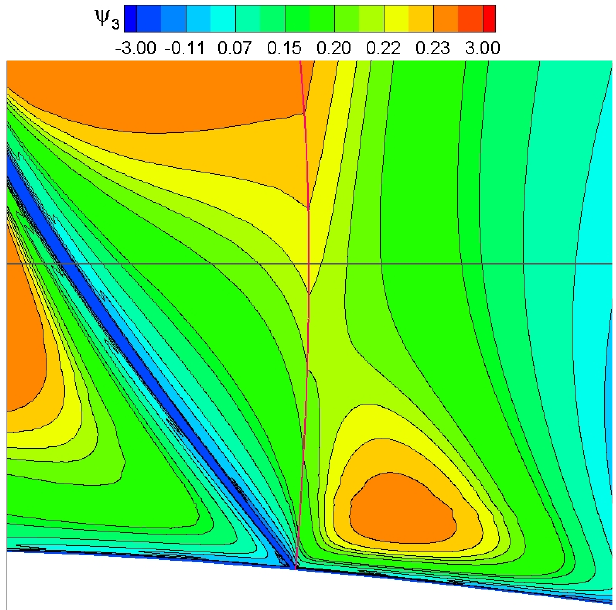
Figure 12. Flow past a NACA0012 airfoil at M = 0.8 and α = 1.25°. Contour plot for the adjoint y − momentum variable ψ 3 near the shock. The shock and the cutting line are indicated for reference.